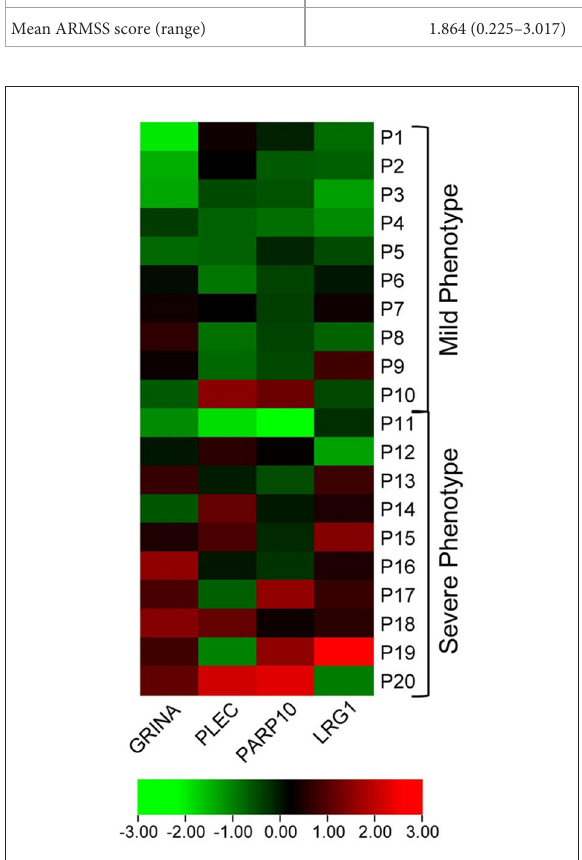
FIGURE1 Heat map visualizing differential expression in MS-VSE genes in the extremes of MS phenotype discovery cohort. The color legend illustrates the coding by log-fold difference in expression (P1 = Patient